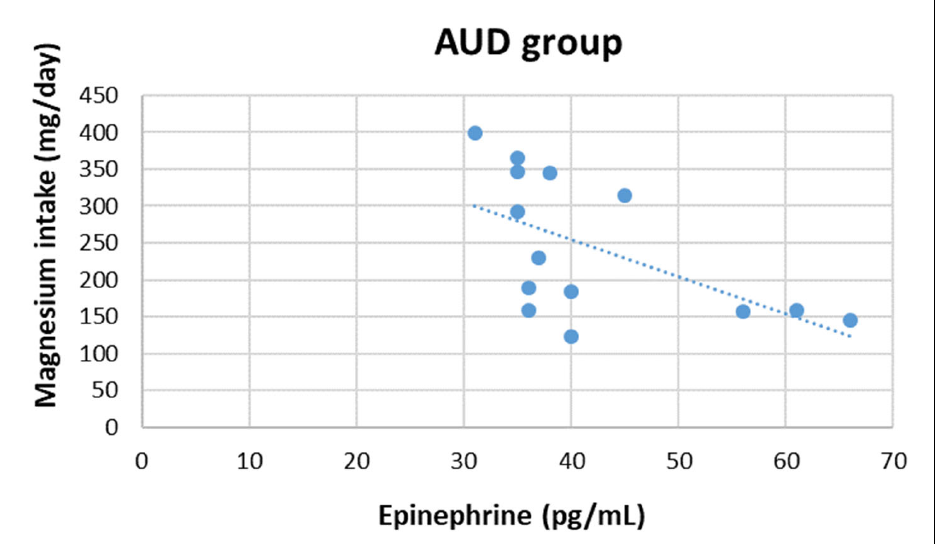
Figure 1. Correlation between plasma epinephrine concentrations and daily magnesium intake in AUD group.